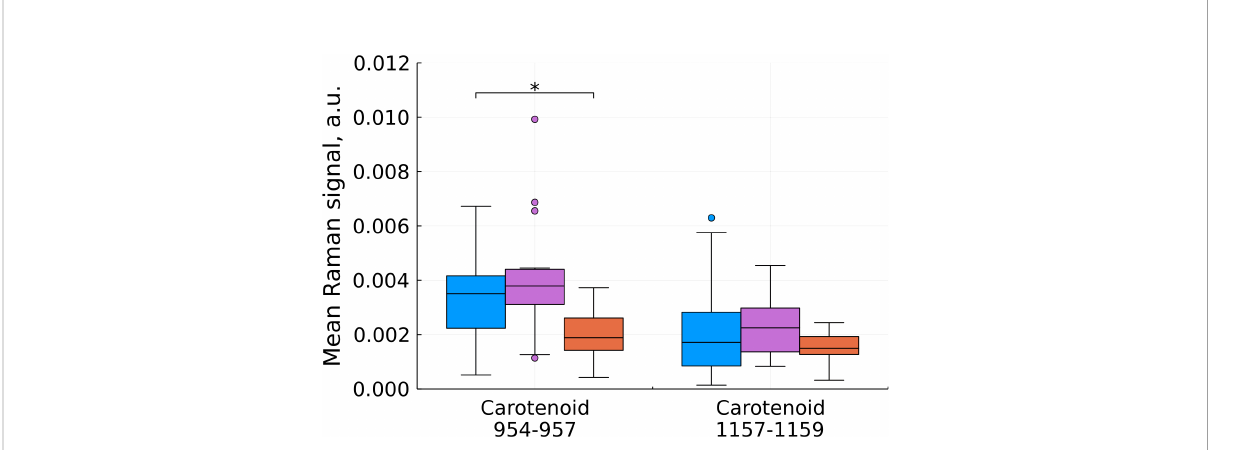
FIGURE 5 Mean Raman signal in bands of carotenoids (blue – normal tissue, magenta - tumor edge, orange - tumor center). Numbers in horizontal labels denote the range of Raman shifts.